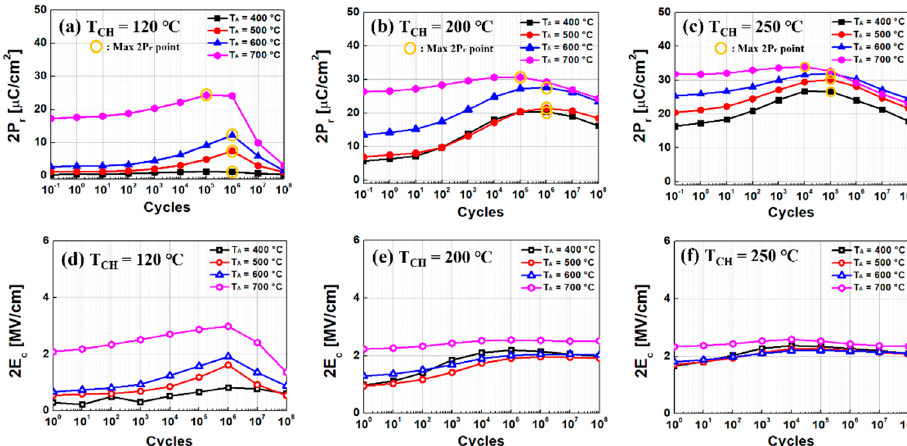
Figure 8. Measured representative ferroelectric characteristics (i.e., remnant polarization (2P r ) and/or coercive electric field (2E c )) versus cycles, for given three different chamber temperatures, ( a , d ) 120 °C, ( b , e ) 200 °C, and ( c , f ) 250 °C with four different annealing temperatures (T A from 400 °C to 700 °C). The yellow − colored circle indicates the max point of 2P r .